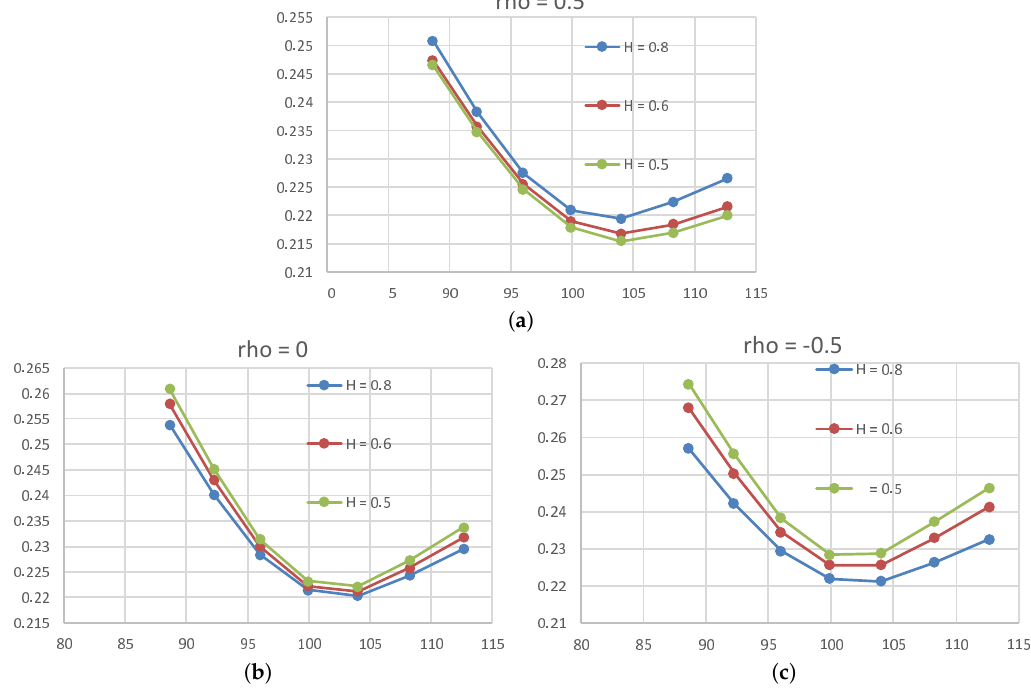
Figure 5. Volatility smile with respect to correlation ρ 1,2 . ( a – c ) show the volatility smile of ρ 1,2 = 0.5, 0, and − 0.5, respectively. The maturity is T = 0.16 and the other parameters are listed in Table